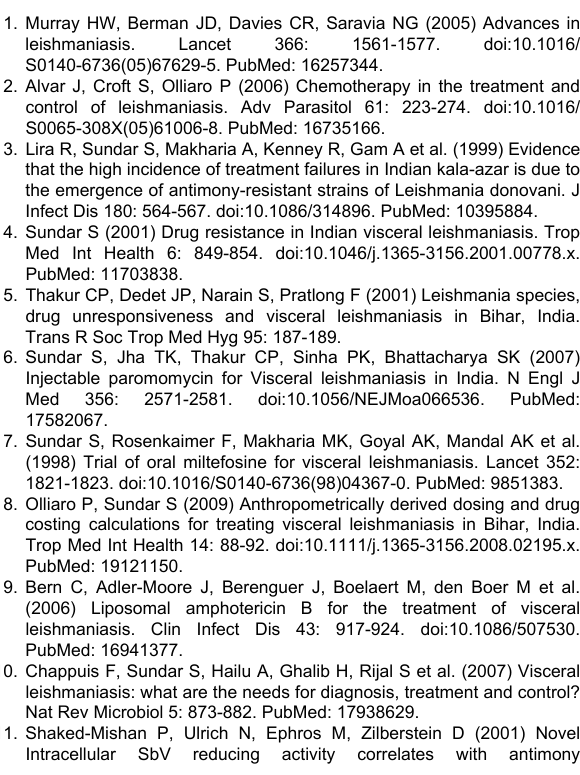
Table S1. Genes whose expression of the protein product was significantly modulated in L. infantum